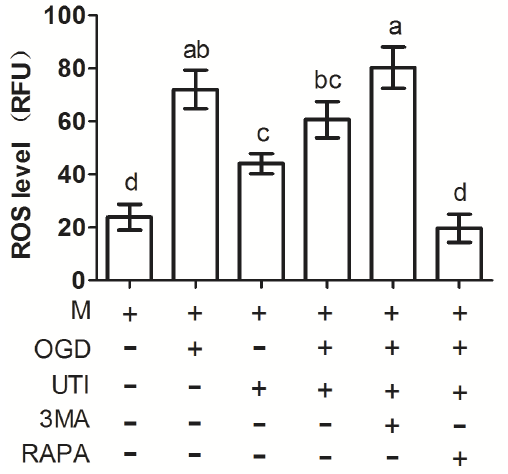
Figure 6: UTI affected the ROS level in macrophages through autophagy. M Macrophage; OGD: Oxygen glucose deprivation; UTI: Ulinastatin.; 3MA: 3-Methyladenine; RAPA: Rapamycin. Bars with different letters are significantly different (p <